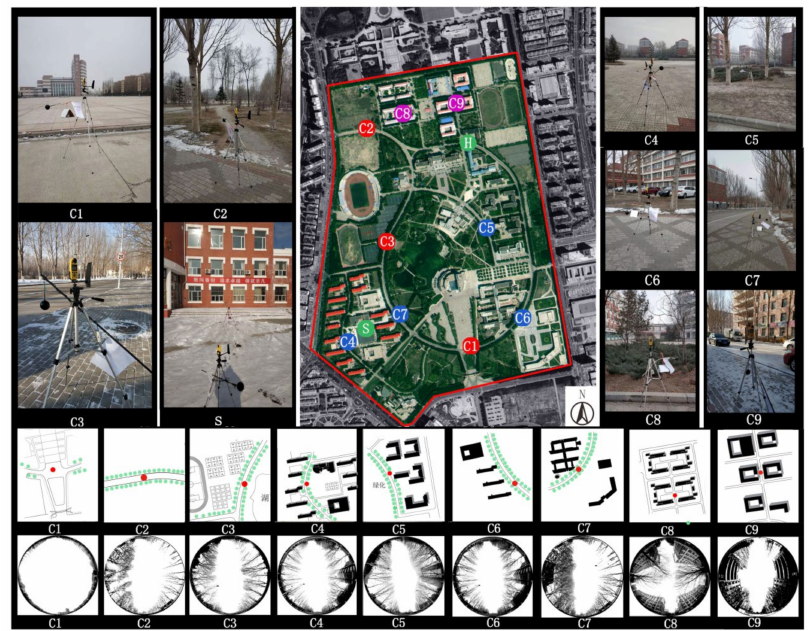
Figure 3. Arrangement of monitoring sites (C1–C9) and fisheye lens photos. Each color represents a type of street for easy contrast.